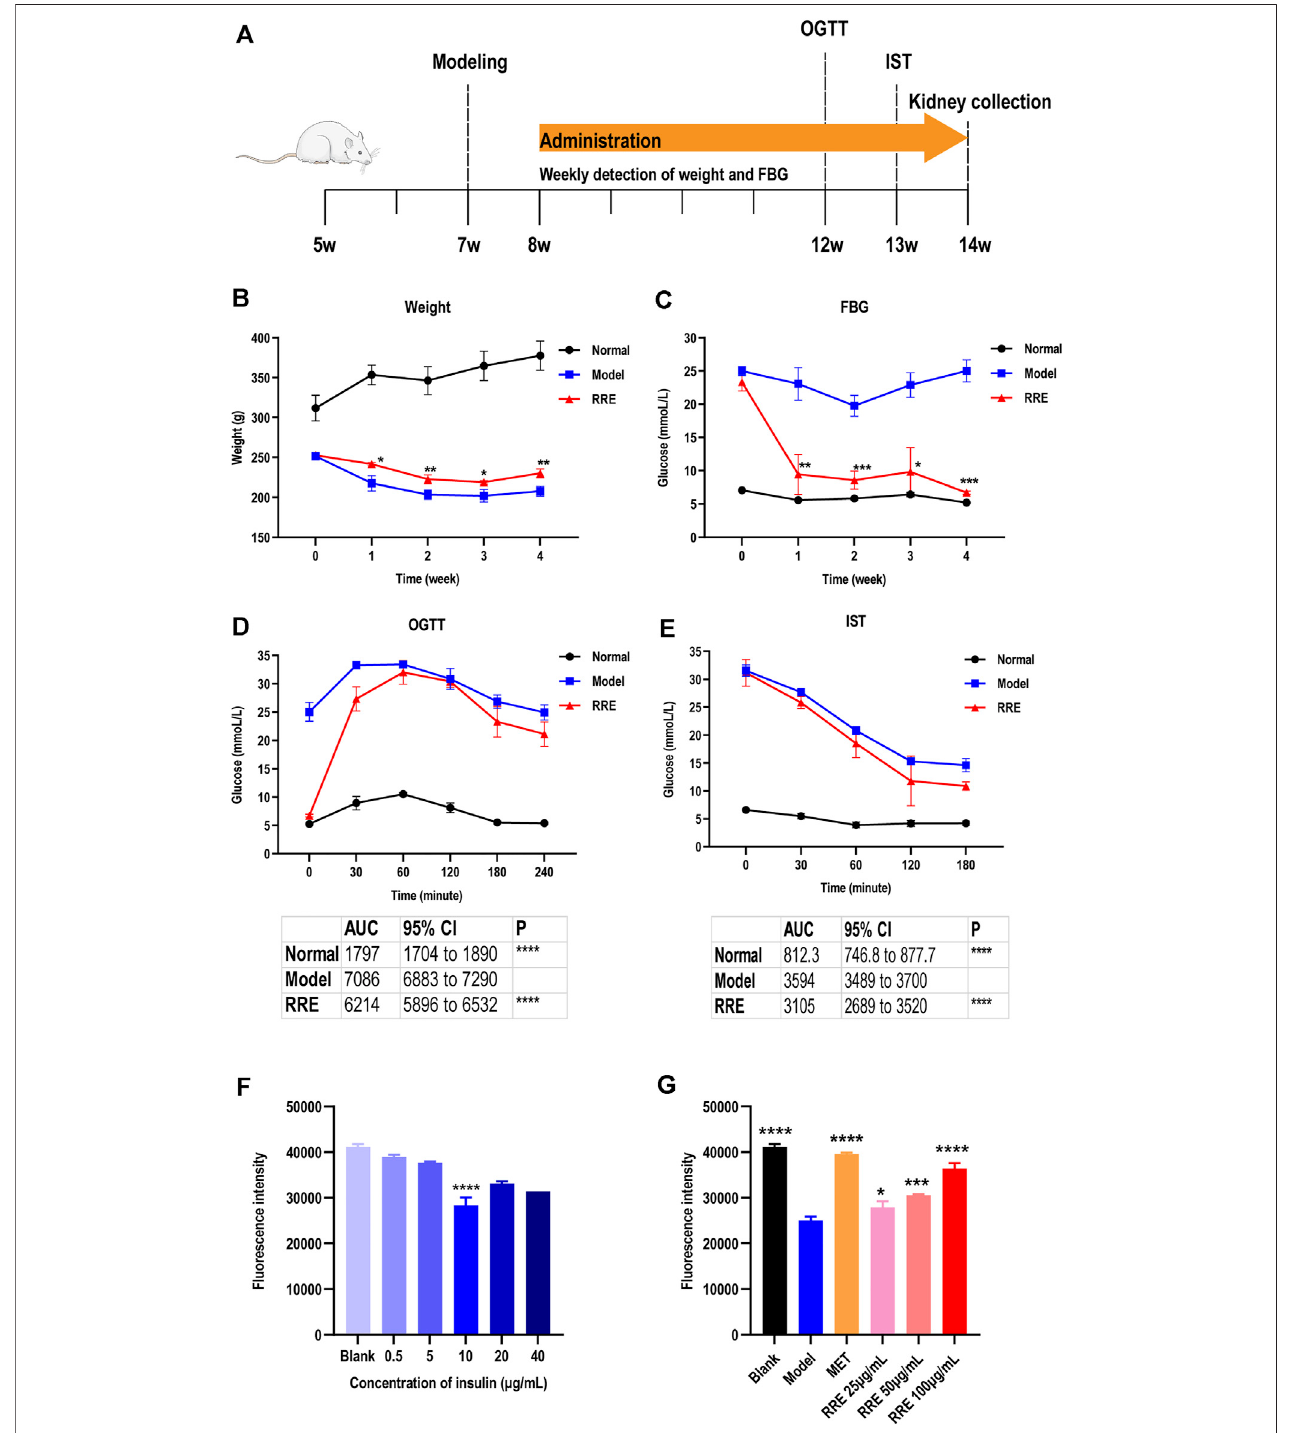
FIGURE 1 | Antidiabetic effect of RRE in in vivo and in vitro studies. (A) Schematic timetable for the suggested antidiabetic experiments in vivo . The SD rats were induced by STZ at 7 weeks of age. After 4 weeks of RRE administration, the metabolic phenotype of the rats was evaluated by an oral glucose tolerance test (OGTT) at 12 weeks of age, followed by 1 week of recovery time and subsequently an IST. (B) Weekly weight of the SD rats in different groups. (C) Weekly FBG of the SD rats in differentgroups. (D) BloodglucoseoftheSDratsateachtimepointintheOGTT.Thetableshowstheareaunderthecurve(AUC)andits95%CI. (E) Bloodglucose at each time point in the insulin sensitivity test. The table shows the area under the curve (AUC) and its 95% CI. (F) In fl uence of different concentrations of insulin on glucoseuptakeinHepG2cells.Glucoseuptakewascharacterizedby fl uorescenceintensityof2-NBDG.****,comparisonwiththeblankgroup, p < 0.0001. (G) Effectsof different concentrations of RRE on glucose uptake in the HepG2 cells with insulin resistance (IR). Glucose uptake was characterized by fl uorescence intensity of 2- NBDG. MET, Metformin. *, **, ***, ****, comparison with the model group, p < 0.05, p < 0.01, p < 0.001, p < 0.0001, respectively.